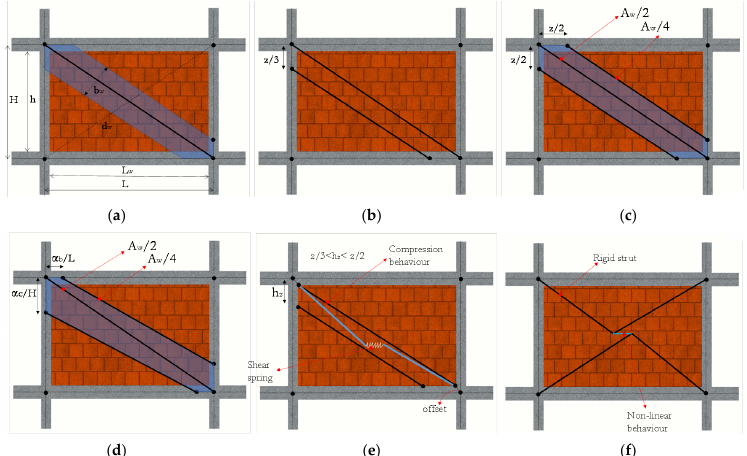
Figure 2. Macro-modelling approaches: ( a ) Holmes [26] single strut ( b ) [33] two-strut approach, ( c ) Chrysostomou et al. [29] three-strut approach, ( d ) El-Dakhakhni et al. [30] three-strut approach, ( e ) Crisafulli [28] macro-model, ( f ) Furtado et al. [27] macro-model.